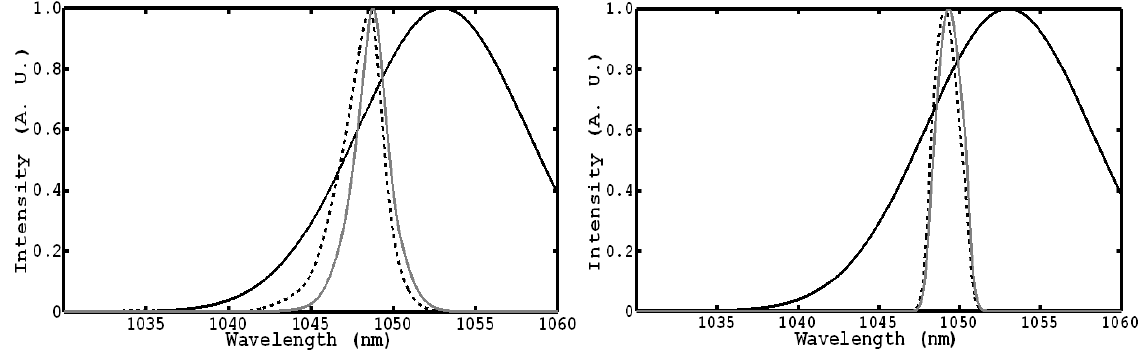
Figure 7. Output spectra for a hybrid amplification chain with pre-amplifier based with Yb:CaF ( left ) and Yb:YAG ( right ). The solid black line represents the initial spectrum, 2 the black dashed line the output spectrum from the pre-amplifier and the grey line the output spectrum after the power